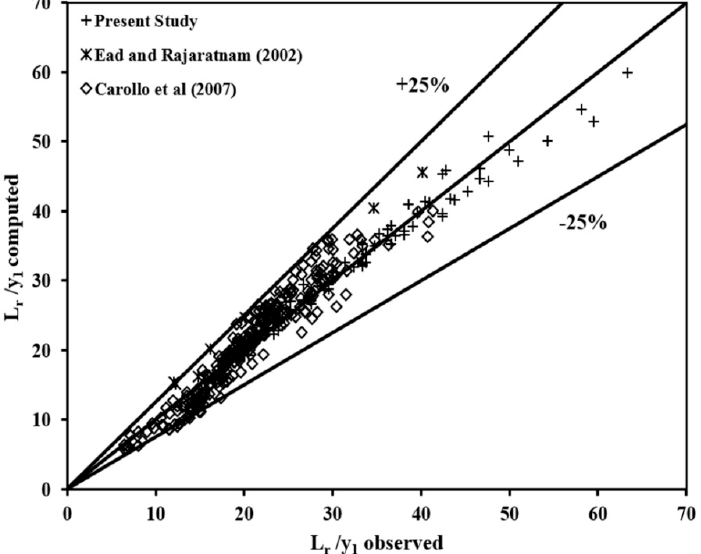
Figure 18. Comparison between the experimental values of the ratio L r / y 1 and the values computed by Equation (34).